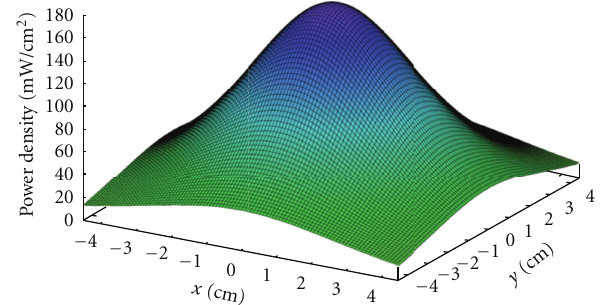
Figure 1: Three-dimensional model demonstrating the power density (mWcm − 2 ) distribution of the emission from the 405 nm ENFIS QUATTRO LED array across a 9 cm agar